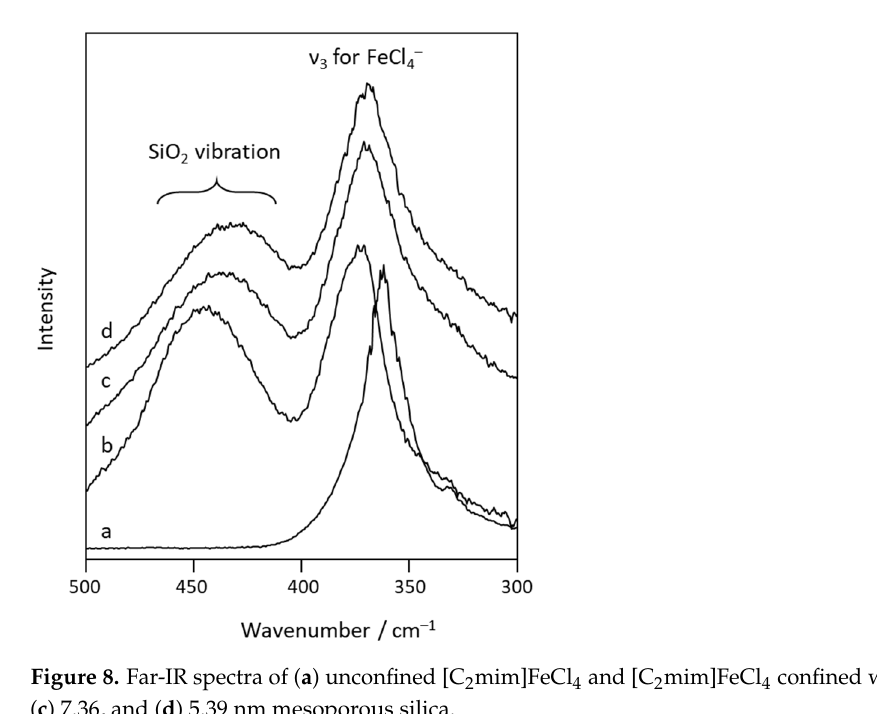
Figure 7. Raman spectra of ( a ) unconfined [C 2 mim]FeCl 4 and [C 2 mim]FeCl 4 confined within ( b )